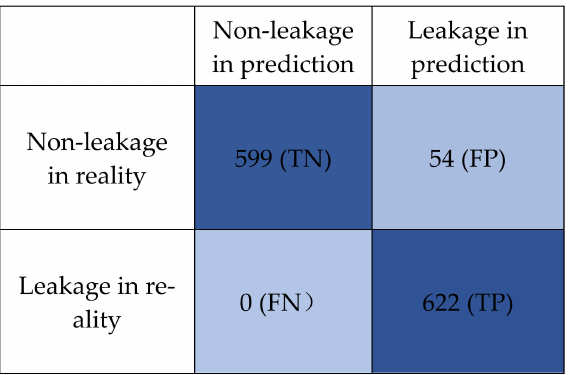
Figure 16. Confusion matrix of the validation of the Random Forest Model.